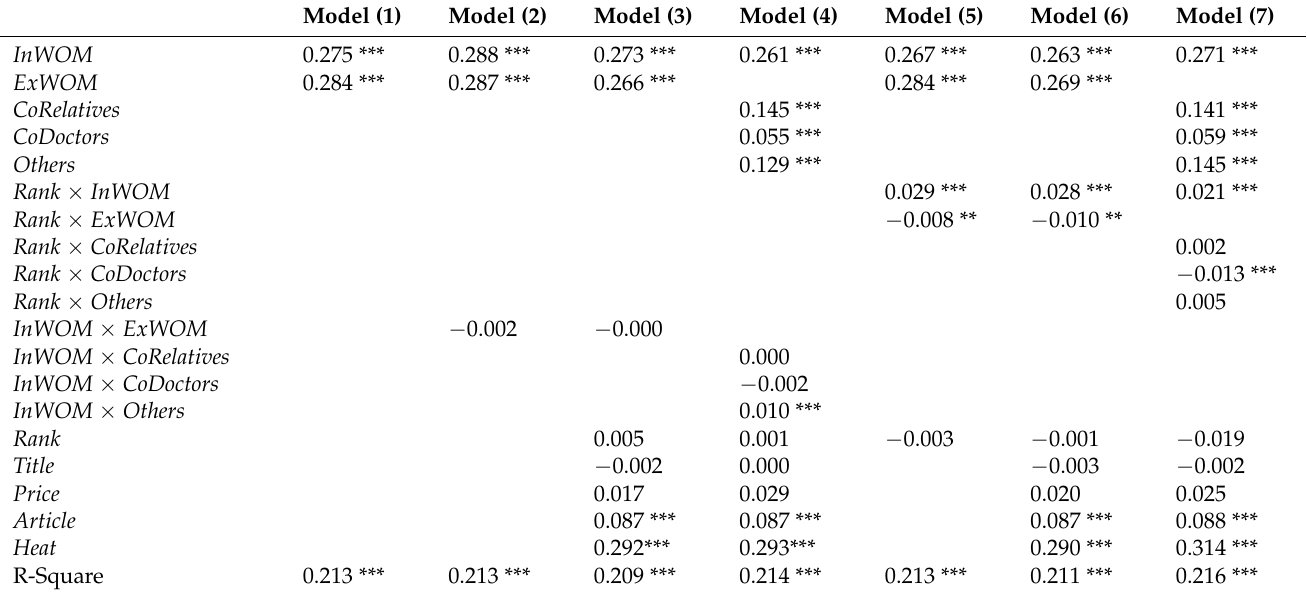
Table 2. Hierarchical regression results using FEM.